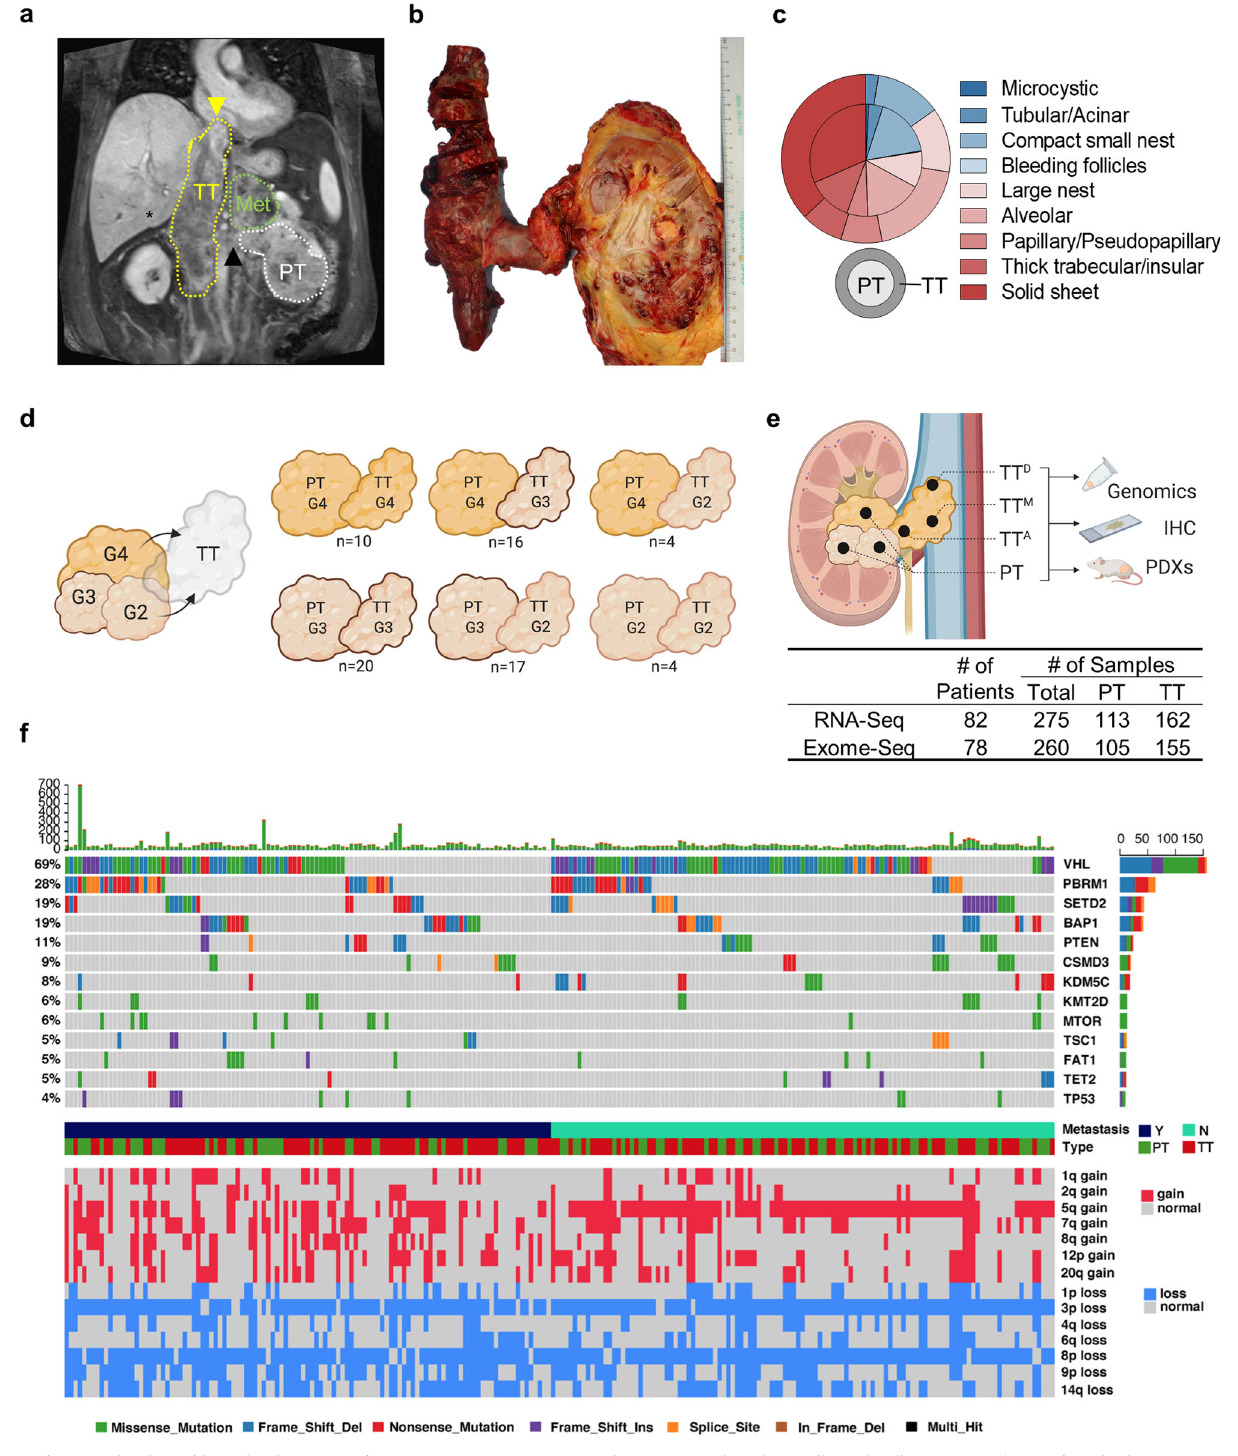
Fig. 1 Characterization of invasive intravascular RCC tumors. a MRI scan of a patient with a clear cell renal cell carcinoma (ccRCC) and inferior vena cava (IVC) thrombus. Coronal T1-weighted fat saturated contrast-enhanced spoiled gradient echo image acquired during the nephrographic phase shows a large left renal mass (white dotted line) extending into the proximal renal vein (black arrowhead). Tumor thrombus extends into the IVC (yellow dotted line) with its distal tip (yellow arrowhead) above the diaphragm and entering the right atrium (Level IV). A large heterogeneous left adrenal metastasis (green dotted line) is present. b Macroscopic image of a primary tumor (PT) and tumor thrombus (TT) from the same patient. c Summarized architectural patterns (indolent (microcystic) to aggressive (solid sheet)) within PT (inner circle) and TT (outer circle) in 71 ccRCC patients with intravascular TT. d Representation of microscopic analysis of PT-TT paired samples based on grade. e Illustration showing multi-region sampling of invasive tumor samples for sequencing, PDX generation, and histological analyses. PT primary tumor, TT-A adjacent thrombus, TT-M middle thrombus, TT-D distal thrombus. f Overview of mutations, CNVs, and clinical parameters for ccRCC patients.